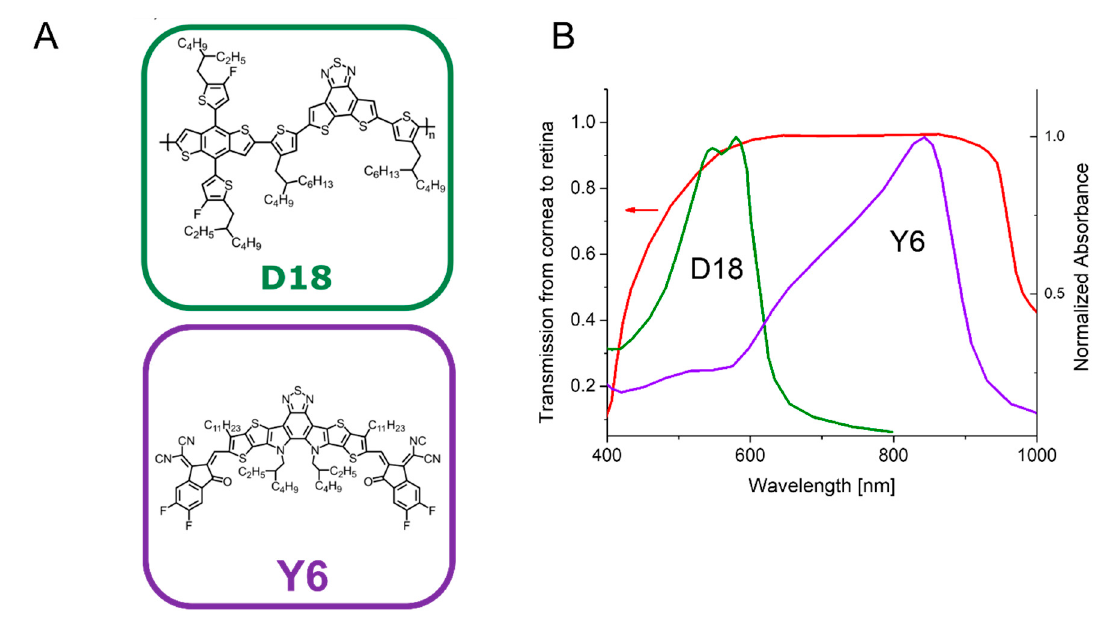
Figure 1. ( A ) Chemical structure of D18 and Y6; ( B ) Comparison transmission from the corona to the retina of a human eye and absorbance of D18 and Y6.